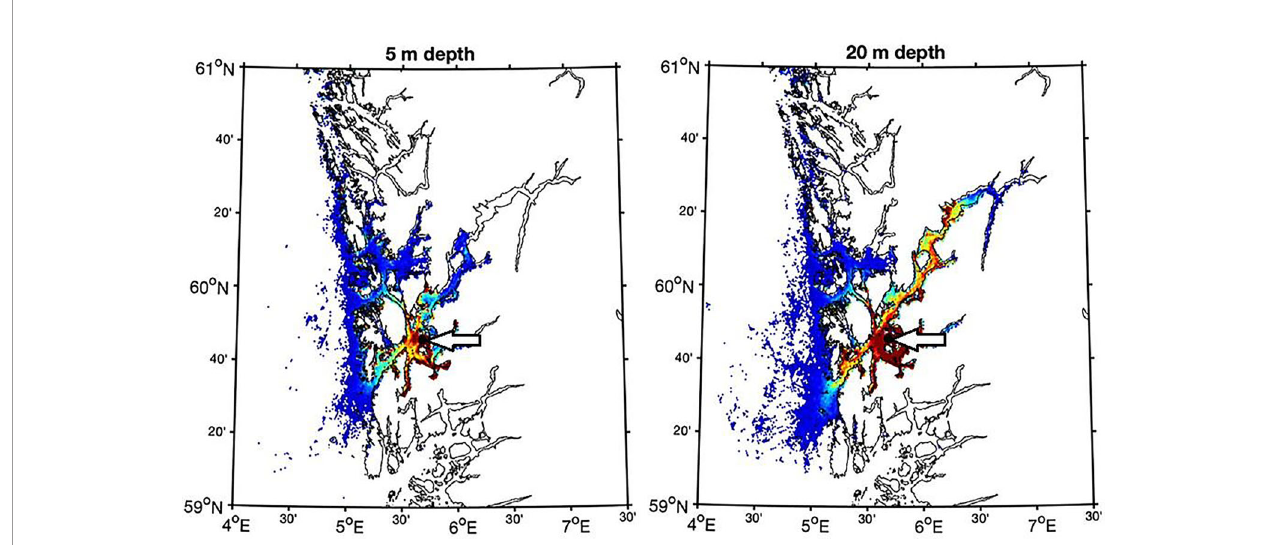
FIGURE 8 | Aggregated particle concentration for particles released in the outer part of the Hardangerfjord (St. HA5, location indicated by arrow) for drift at 5 m (left) and 20 m (right) depths. Dark blue colour represents low aggregation and red colour high aggregation.